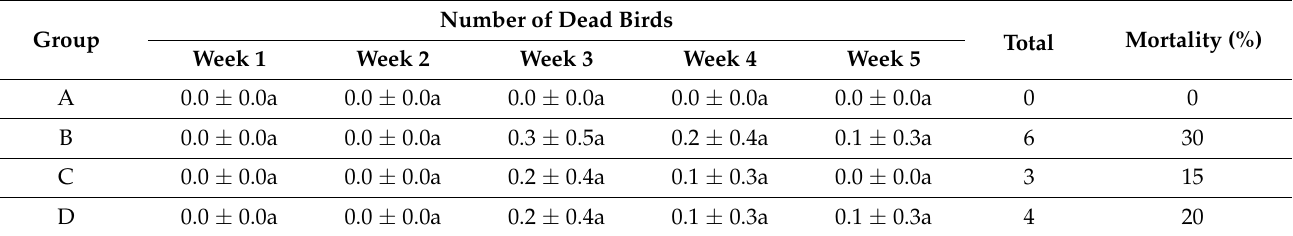
Table 3. Mortality (%) in various groups of